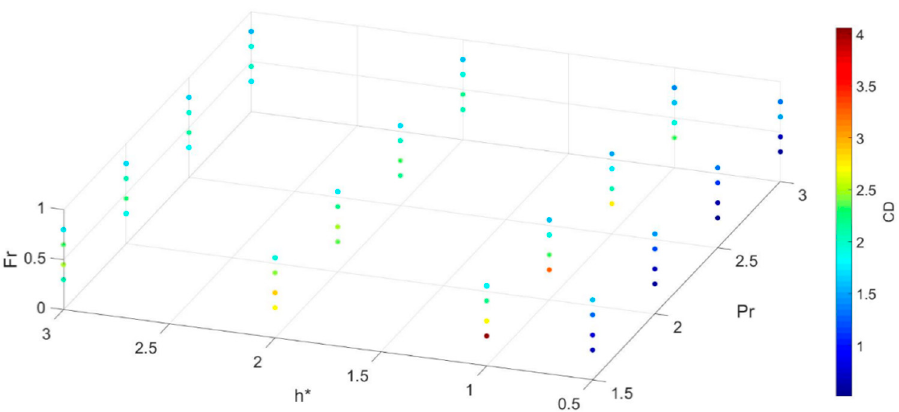
Figure 25. Drag coefficient for box deck based on the proximity ratio (Pr—1.5,2,2.5,3), inundation ratio (h*—0.5,1,2,3), and Froude number (Fr—0.30,0.45,0.65,0.80). These drag coefficients hold for a rectangular deck with an aspect ratio (height:width) of 0.27. Table 6. Comparison of drag coefficients between AS5100 [7] and this study. Red numbers indicate situations when AS5100 [7] fails to be conservative.